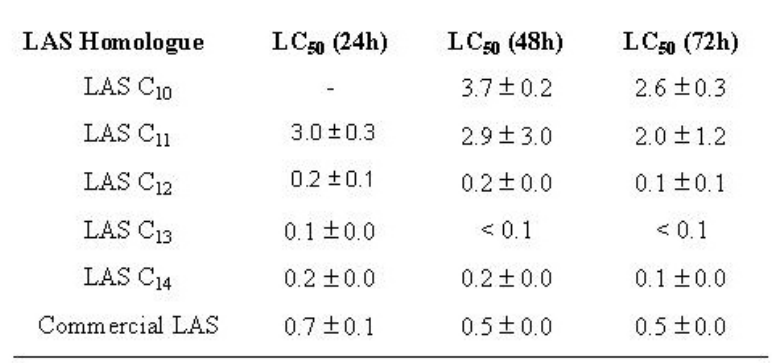
LC values obtained in Larvae Exposure Assays with Different 50 LAS Homologues after 24, 48, and 72 h of Exposure